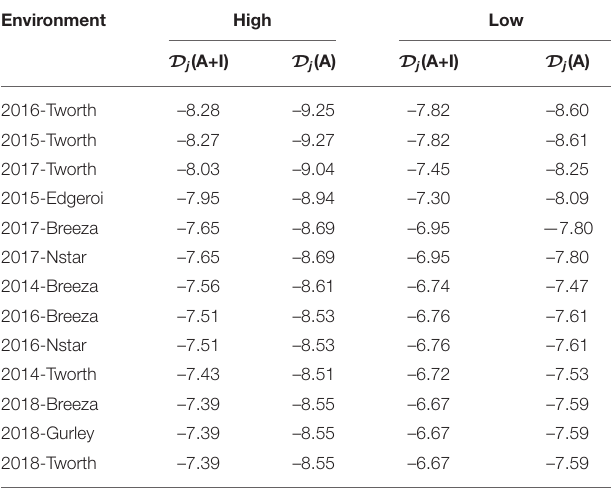
TABLE 2 | Durum example: Diagnostic D j -values based on LMMs with additive and non-additive VE effects [ D j (A+I)] and those based on LMMs with additive VE effects alone [ D j